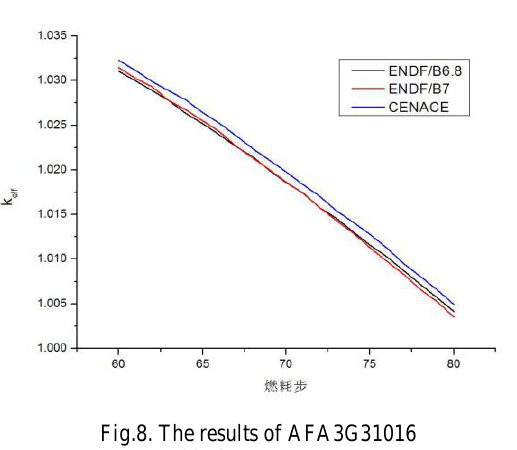
Fig.7. The results of AFA3G31000 assemble from steps 60 to 80